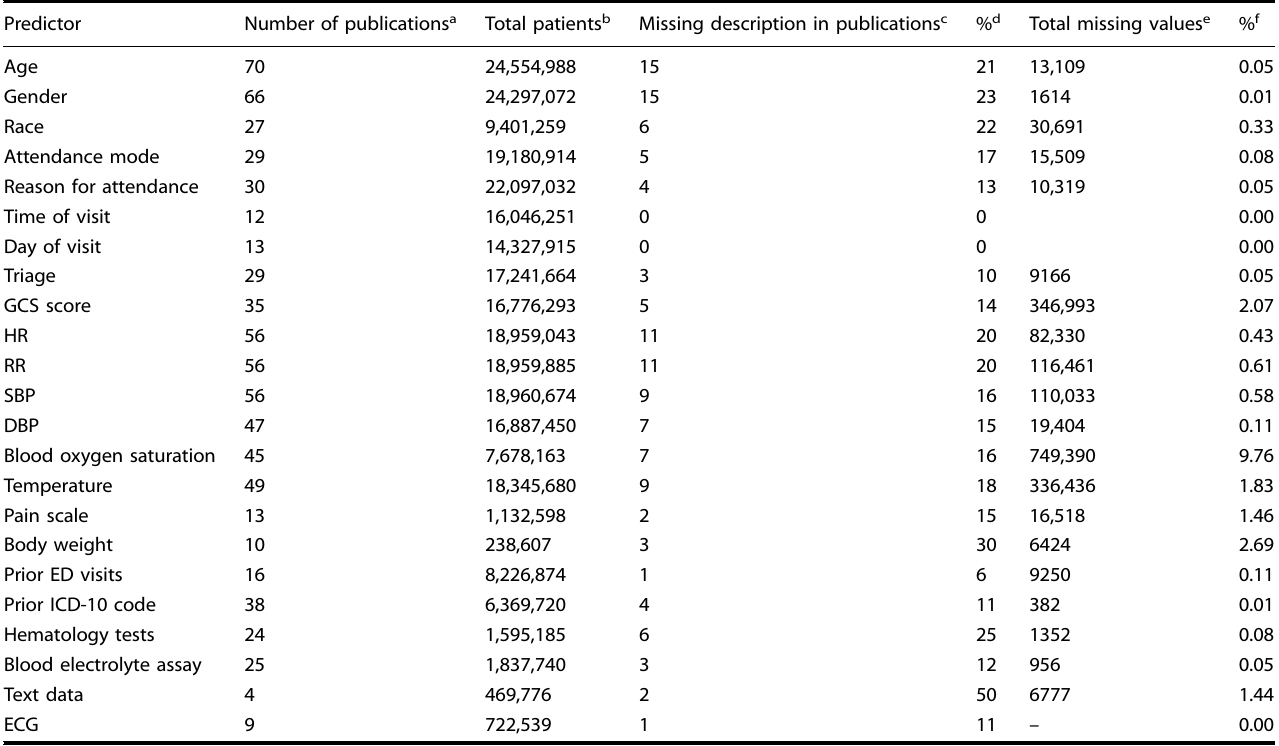
Table 3. Description of missing data in